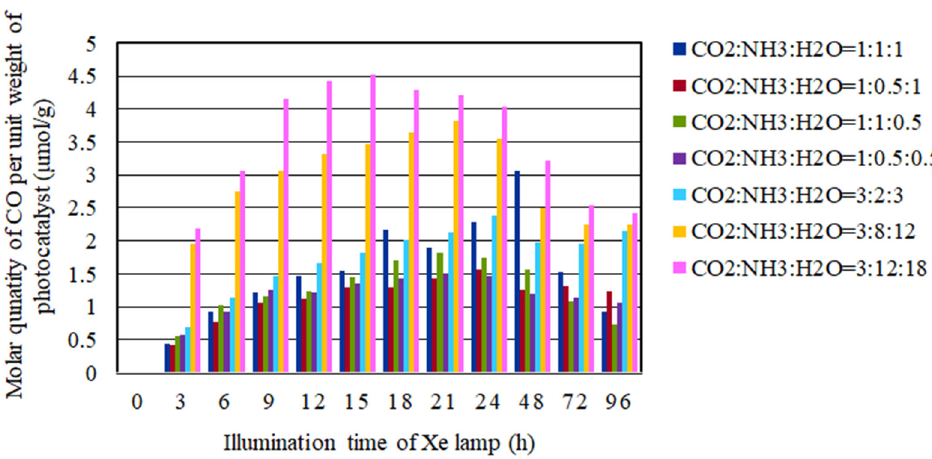
Figure 6. Comparison of molar quantity of CO per unit weight of photocatalyst under the illumination condition of Xe lamp with UV light. The pulse number is 500. The highest CO 2 reduction characteristic is obtained under the condition of the molar ratio of CO 2 /NH 3 /H 2 O = 3:12:18 where the molar quantity of CO per unit weight of photocatalyst is 4.4 mol/g.